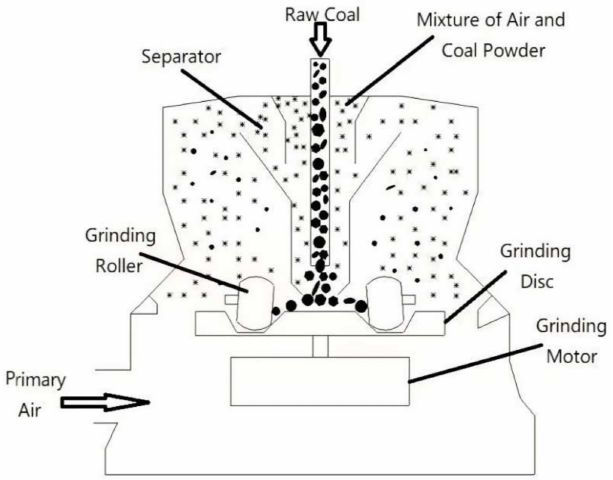
Figure 1. Schematic diagram of the working principle of MPS medium speed coal mill